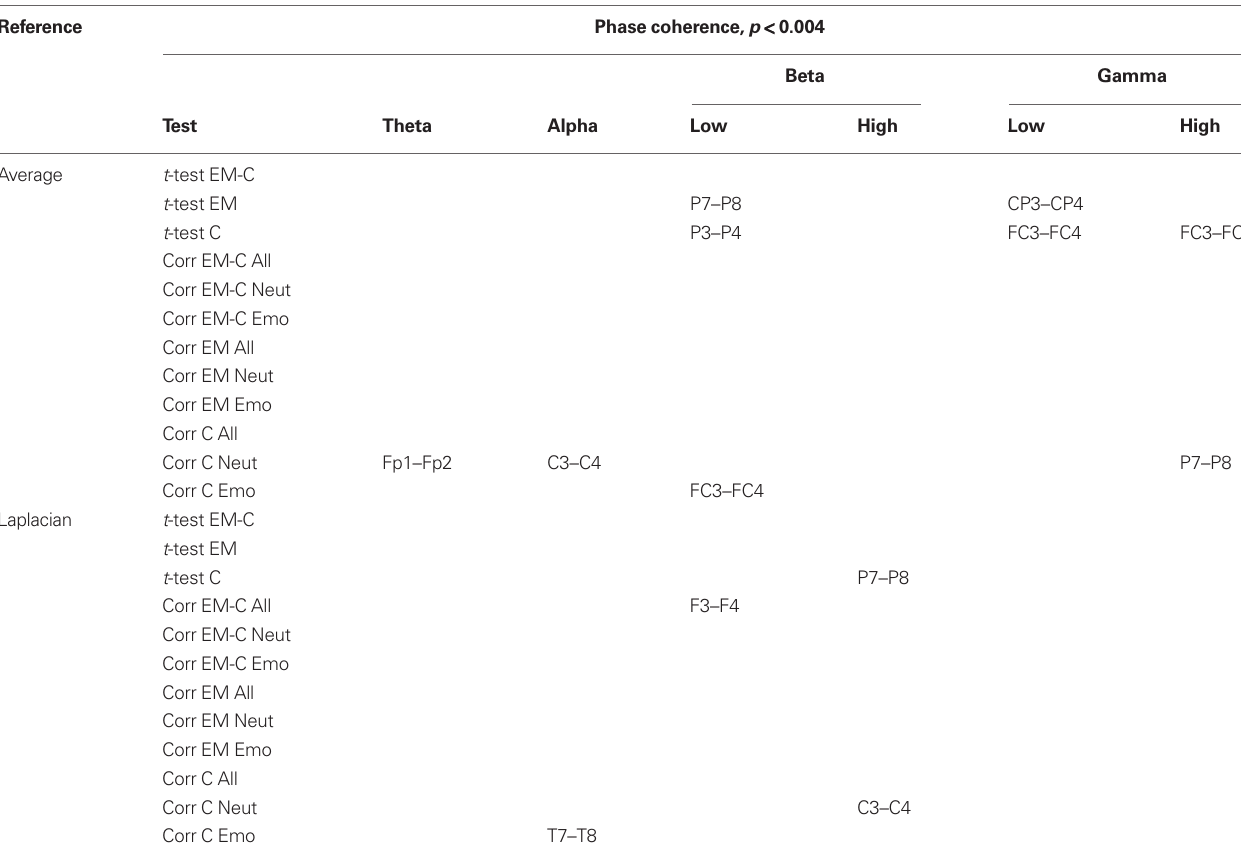
Table 2 | Summary of significant changes in phase coherence for the average and the Laplacian reference scheme (significance threshold adjusted for number of electrode